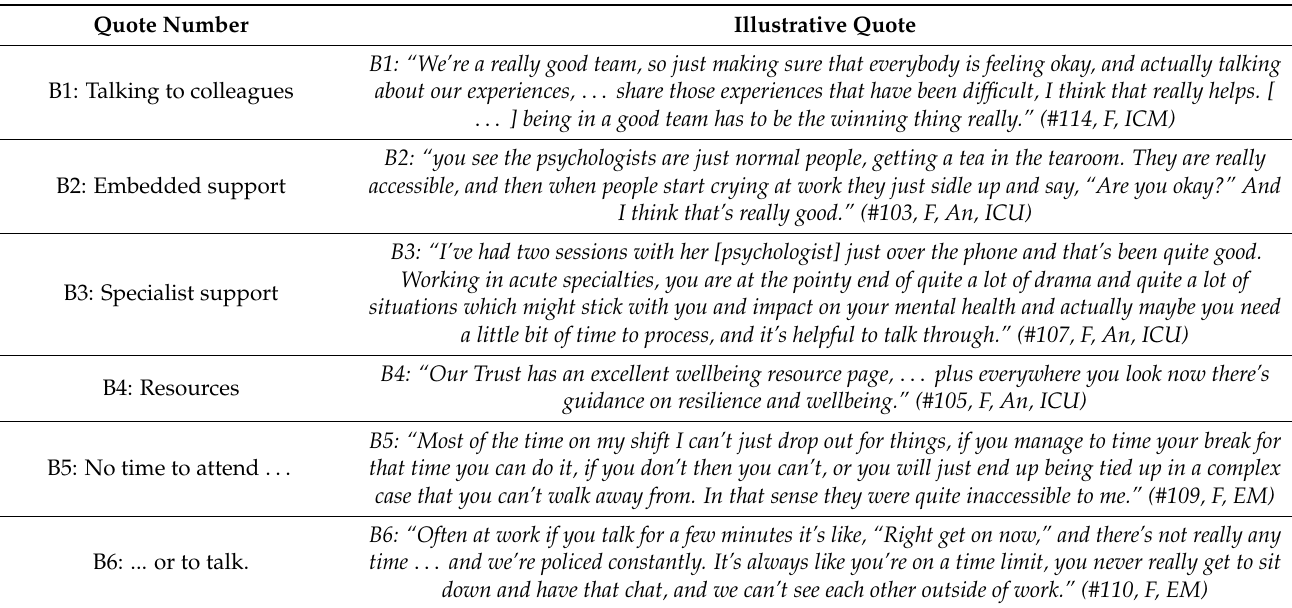
Table 5. Illustrative quotes for Sources of Support